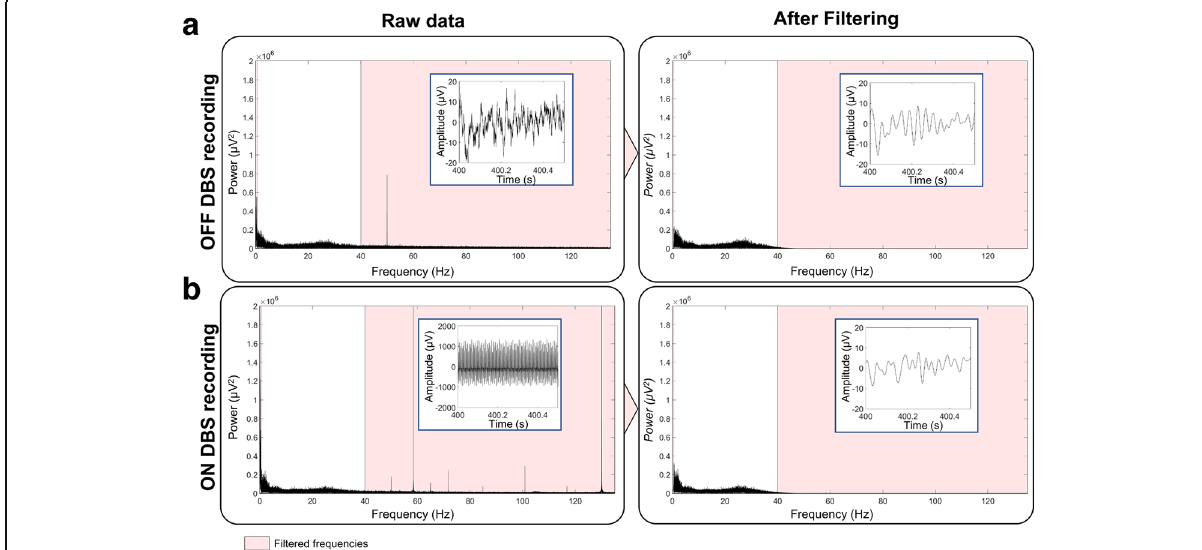
Fig. 1 Power spectrum and EEG time series at rest before (left) and after (right) correction of the DBS artefact. a With DBS turned OFF. b with DBS turned ON. The EEG recording was obtained in a PD patient stimulated at 130 Hz bilaterally in the STN. A low pass filter with a cut-off at 40 Hz was applied to remove the DBS artefact. See (Kibleur et al. 2016) for full description of the data acquisition procedure